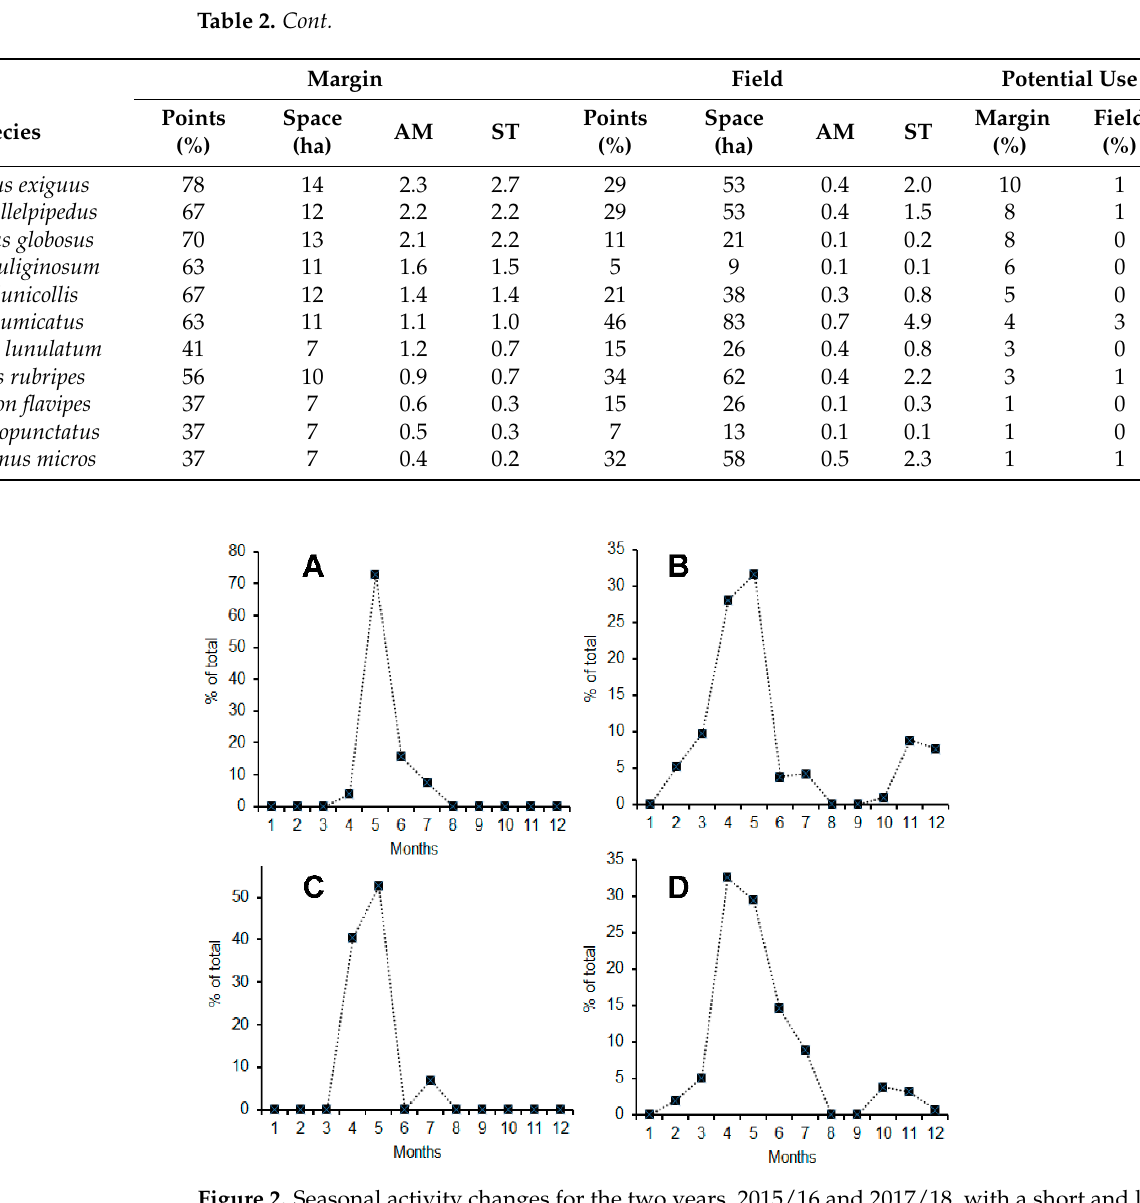
Figure 2. Seasonal activity changes for the two years, 2015/16 and 2017/18, with a short and long activity period of ( A ) Carabus auratus and ( B ) Bembidion tetracolum as typical species of the arable field and ( C ) Limodromus assimilis and ( D ) Carabus nemoralis of field margins with immigration into the field.